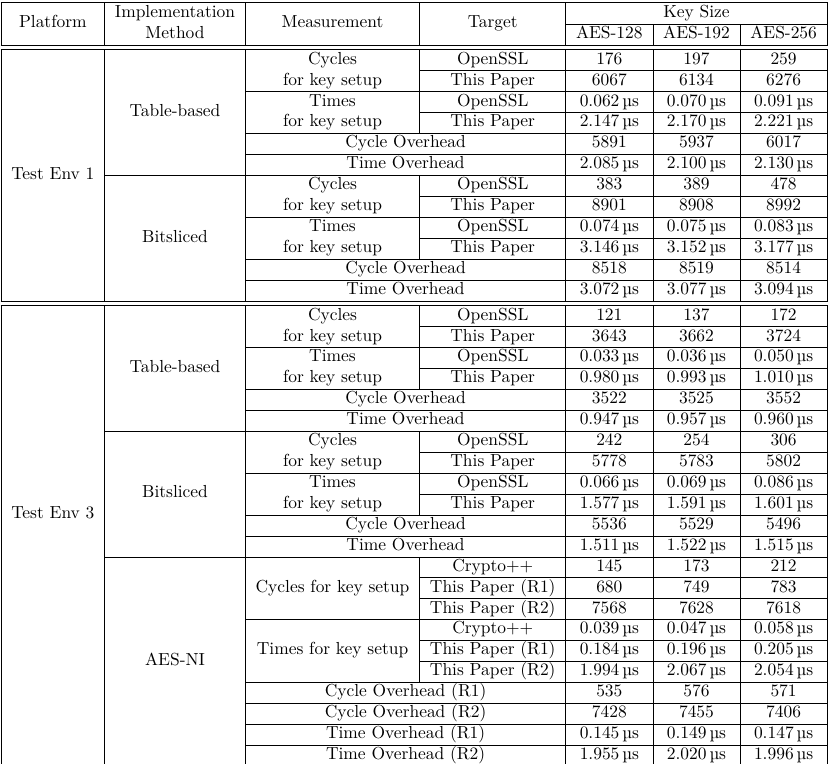
Table 4: Comparison of key-scheduling